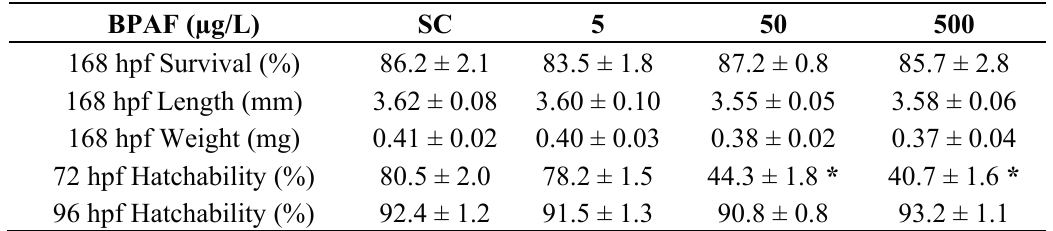
The values represent as mean ± standard error (SEM) of three replicate groups. Asterisk indicates significant difference compared with solvent control (SC) ( * p <